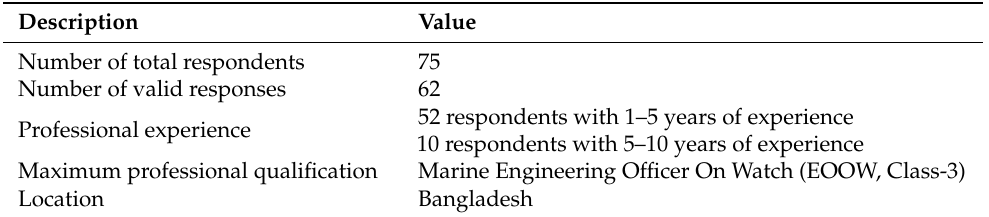
Table 2. Demographics of survey